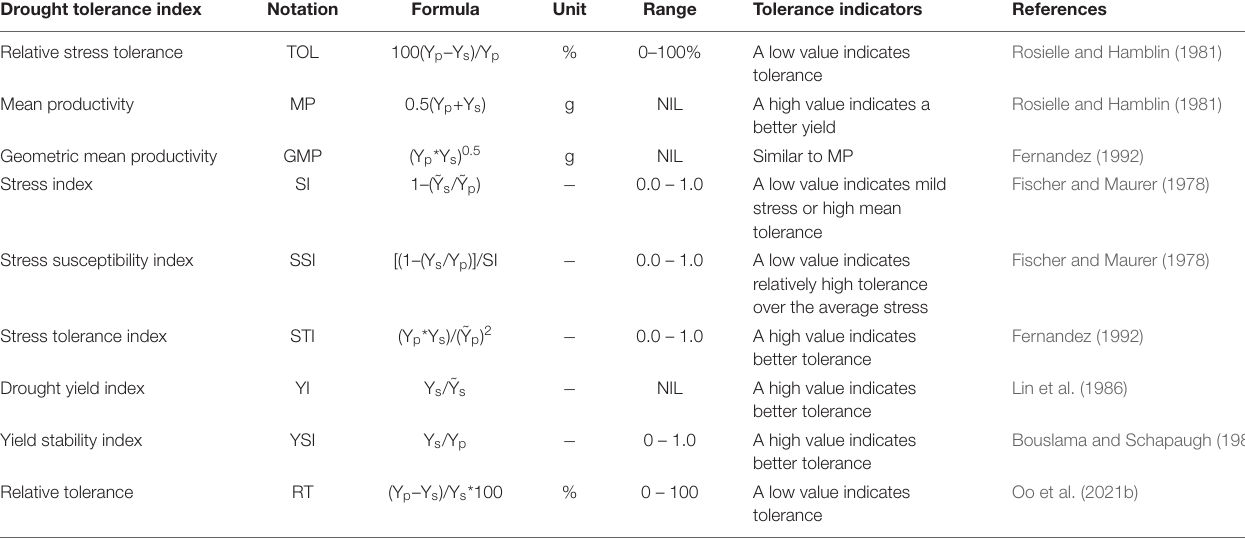
TABLE 1 | Drought tolerance indices used in the study.